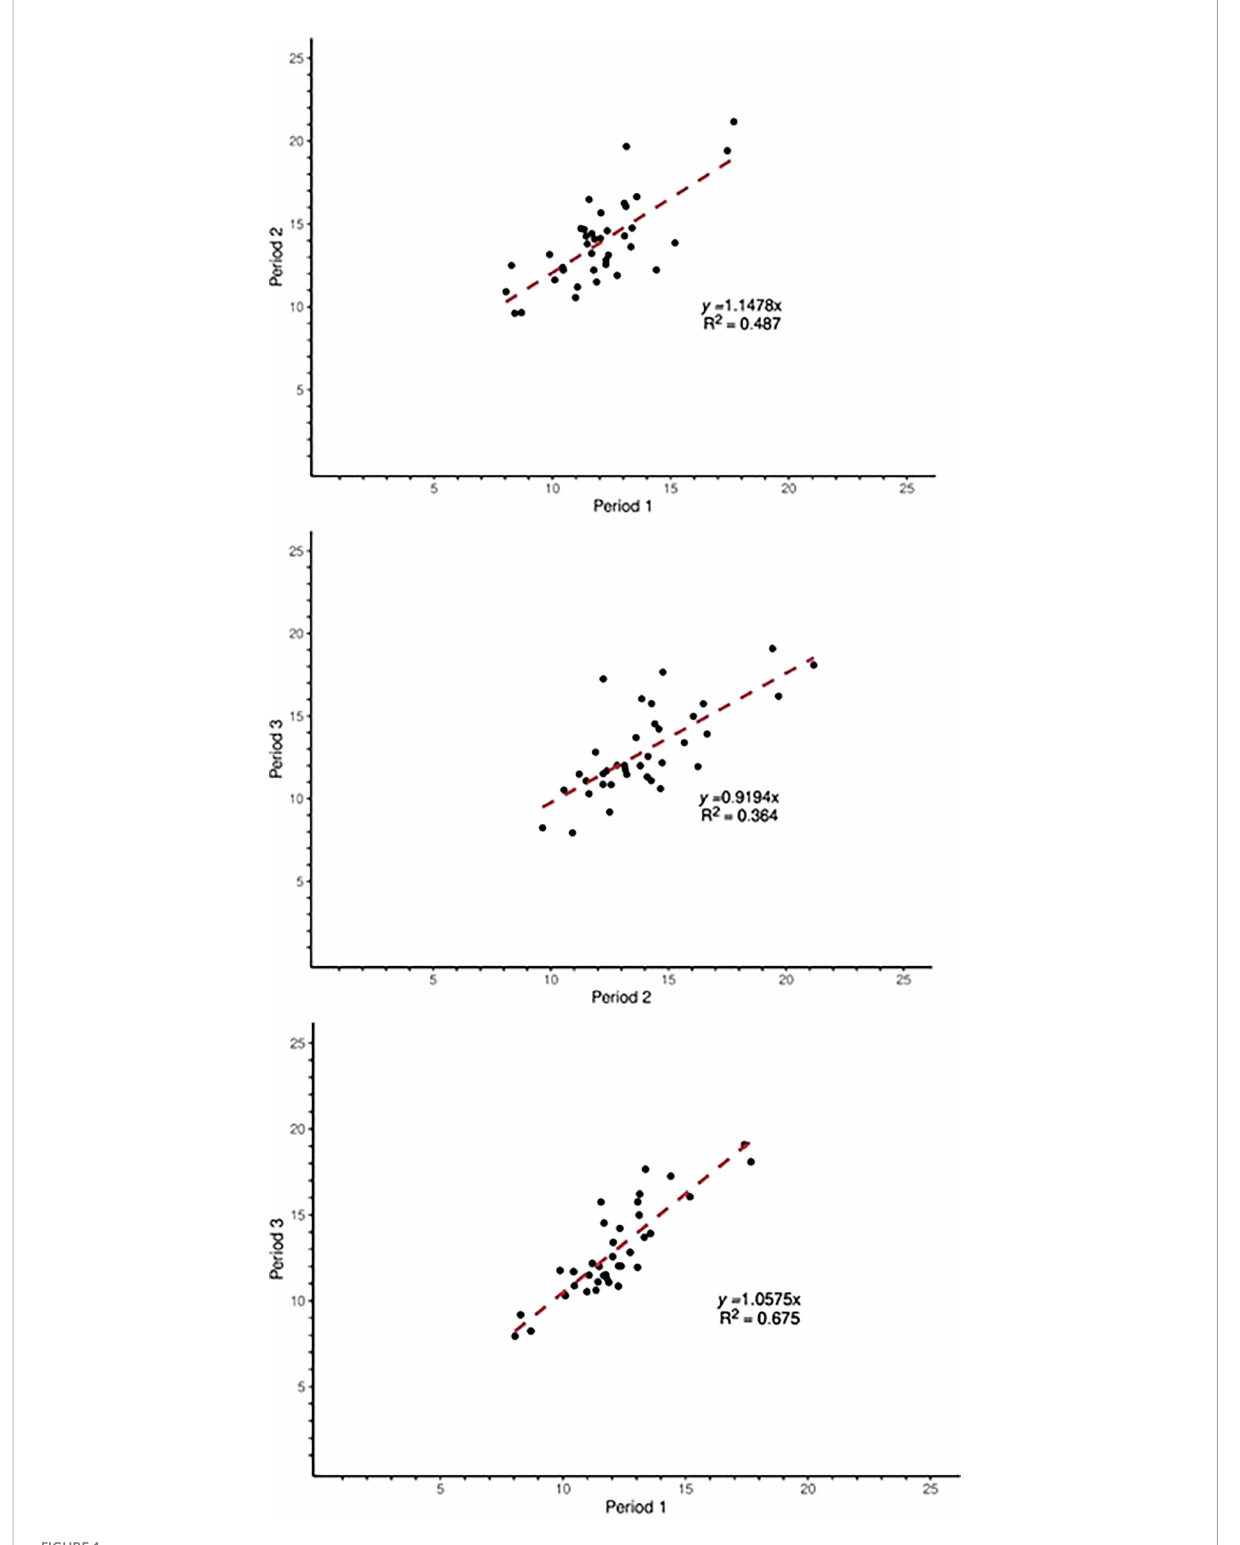
FIGURE 1 Relationships between methane yield (MY) of individual animals across periods. R 2 = coef fi cient of